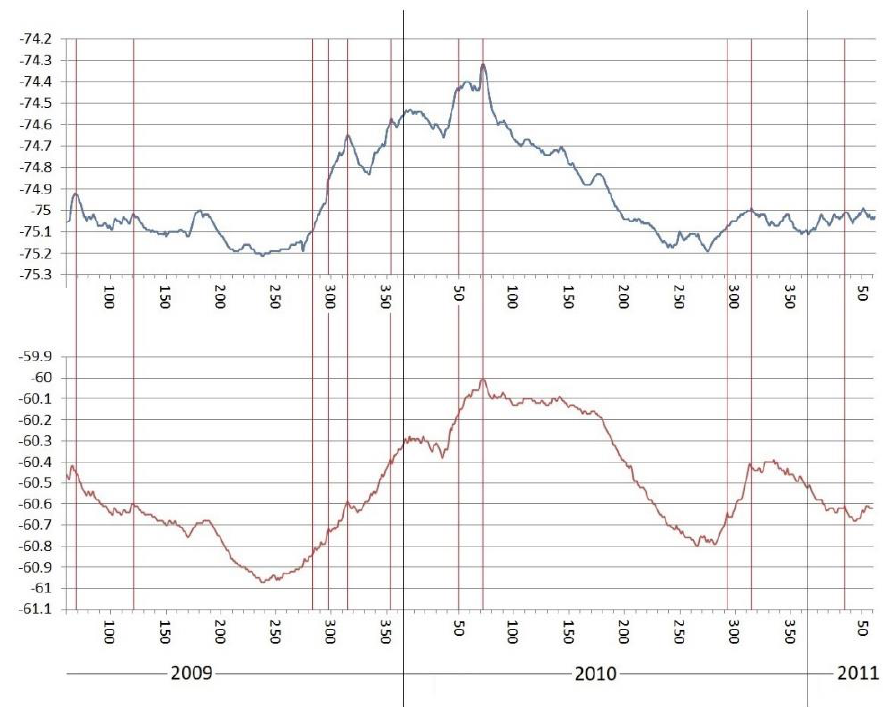
Figure 5. Water table daily fluctuations in well LE-PS17 (above) and BR-NM2 (below) from March 2009 to February 2011; the limits of the recharge events (see Table 1) are marked by red lines. Table 1. Synopsis of the data used for the estimation of S y : final day of the event day#, precipitation P , evapotranspiration E , piezometric level change Δ h ; superscript 1 and 2 refer to well LE-PS17 and well BR-NM2, respectively, 3 refers to the CNR-ISAC base, * indicates that consecutive events have been aggregated; all quantities in mm except ( 𝚹 f − 𝚹 I ) (volumetric depth-averaged moisture content difference,